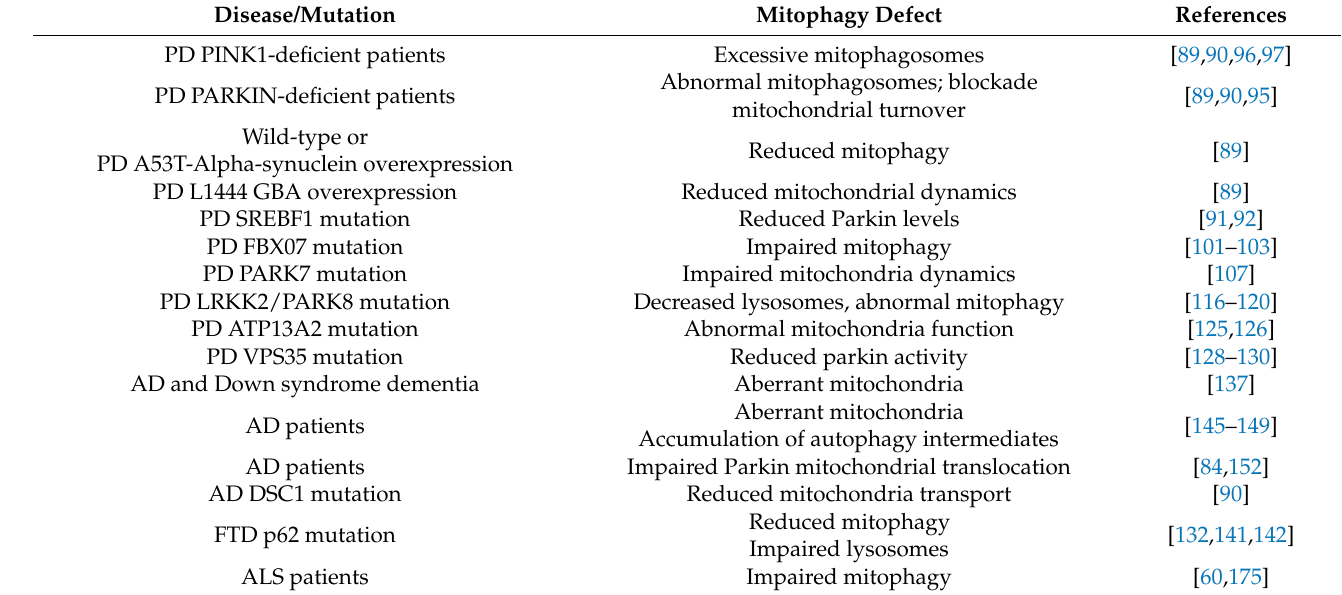
Table 1. Aberrant mitophagy in neurodegenerative and neuropsychiatric diseases. Disease acronyms are the same as those in the text above.